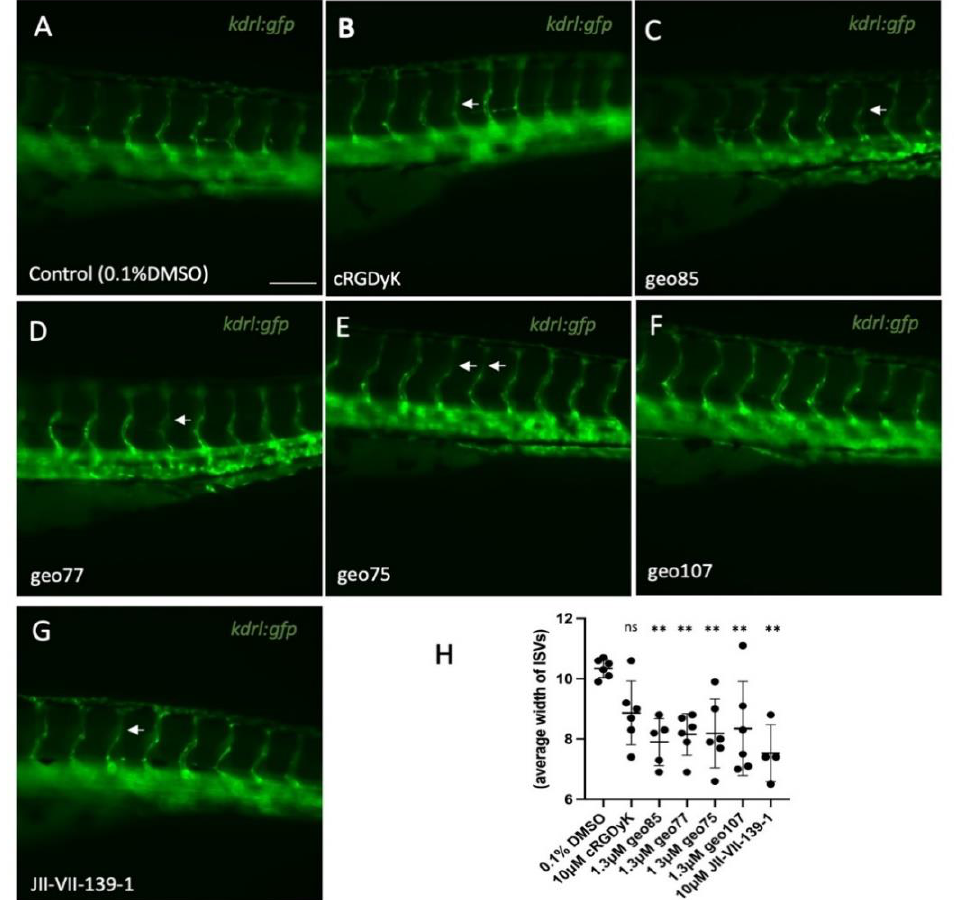
Figure 9. In vivo screening unravels inhibitors of angiogenesis. ( A – G ) Fluorescence microscopy images of representative Tg(kdrl:gfp) embryos treated with the specified compounds from 24 hpf, and DMSO-treated control at 72 hpf. White arrows show sections of ISVs with decreased width. Scale bar, 100 µ m. ( H ) Estimated and presented total width of 8 ISVs per embryo. Width was measured and averaged at three different points (top, middle and bottom point) of each ISV. Compounds JII-VII-139-1 (10 µ M), geo75 (1.3 µ M), geo77 (1.3 µ M), geo85 (1.3 µ M) and geo107 (1.3 µ M), show statistically significant inhibition on the total width of ISVs, while compound c(RGDyK) (10 µ M) shows a non-significant trend at the tested concentration. Data are expressed as mean ± SD ( n = 4–7/group). ** p < 0.05.